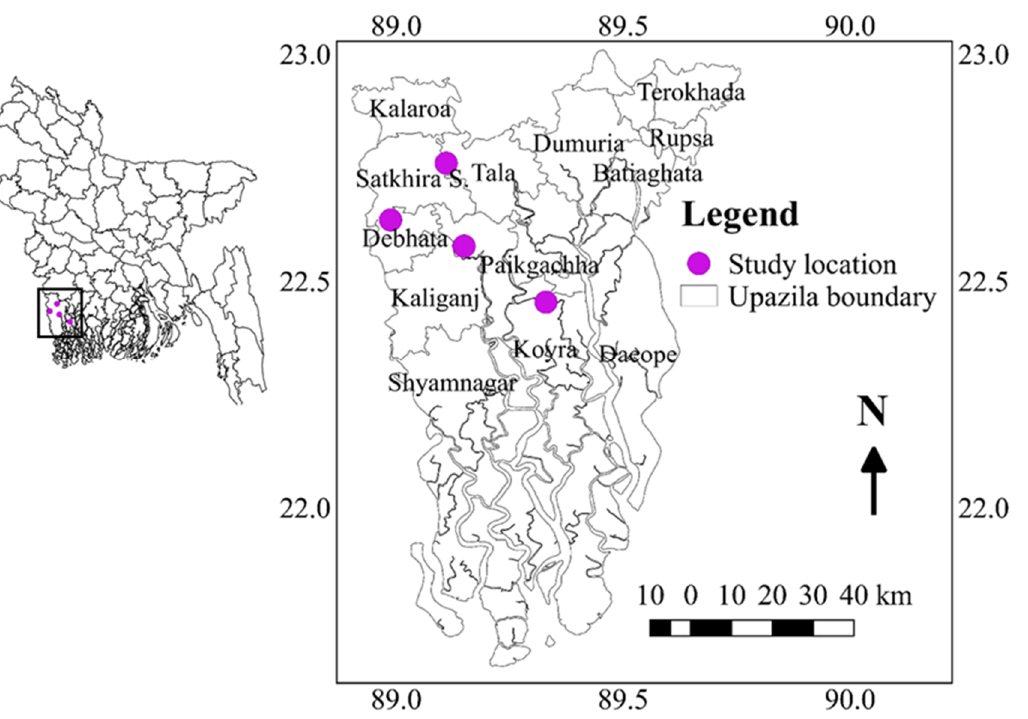
Figure 10. Geographical location of the experimental sites. Table 5. Mean monthly temperatures, wind speed, and rainfall data during the field experiment period in Satkhira and